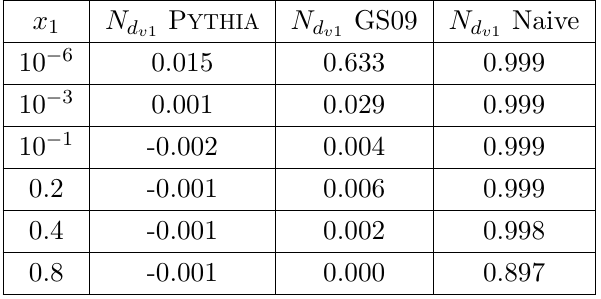
Table 2 . Same as in table 1 but for the R dd ( x 1 , x 2 , Q ) response function. In the ideal situation when the GS sum rules are perfectly satisfied N d